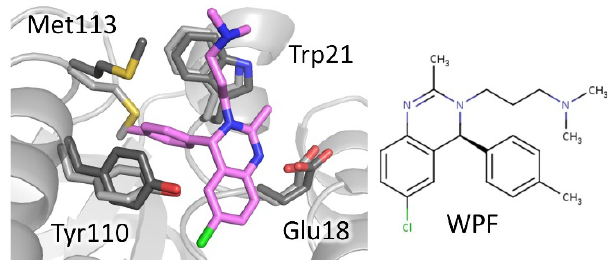
Figure 5. Mode of binding of 3,4-dihydroquinazoline derivatives. Compound WPF, best performing compound of the series, binds to mepacrine binding site (MBS). Critical residues are shown as sticks, light grey for inhibitor-free (PDB: 2wow) and dark grey for inhibitor-bound TR (PDB: 2wpF). Note the displacement of Met113 to accommodate the C4-phenyl substituent.